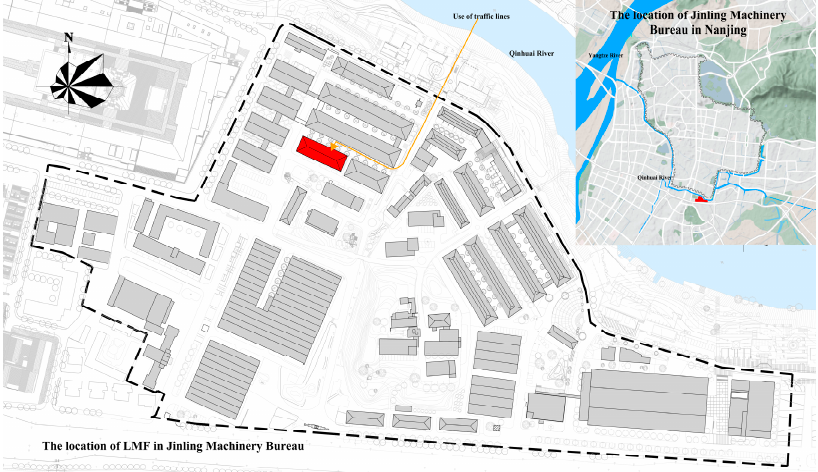
Figure 6. The location of the LMF. Picture by X.X.